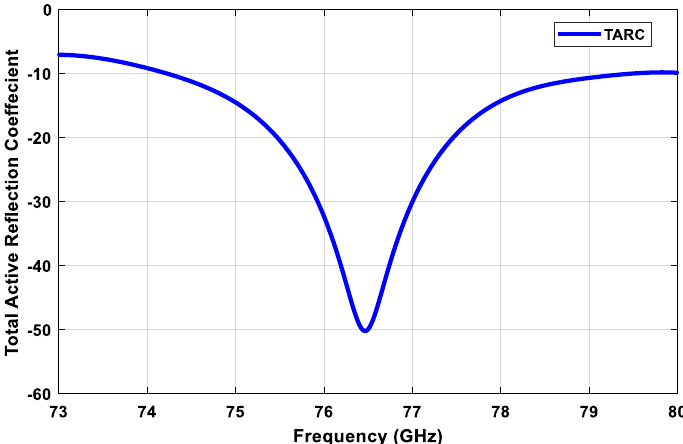
Figure 11. Simulated TARC calculations for the proposed transmitter subarray configuration.